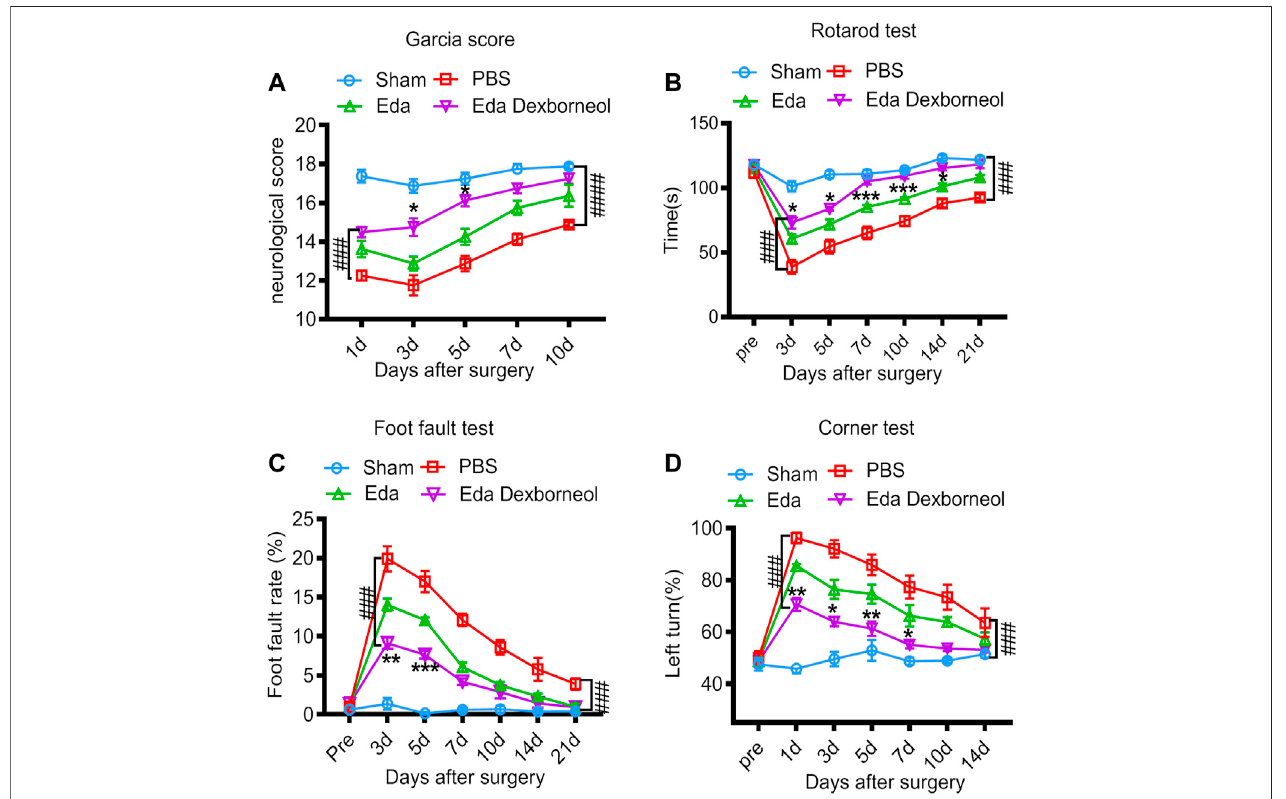
FIGURE 2 | Edaravone dexborneol treatment improves sensorimotor functions after SAH. (A) Neurological scores were determined 1 – 10 days after SAH with the modi fi ed Garcia scoring system. (B – D) Acute sensorimotor dysfunction at 1 – 21 days after SAH was assessed by (A) Garcia score, (B) rotarod test, (C) foot-fault test, and (D) corner test. N = 8/group. Data are given as mean ± SE. * p < 0.05, ** p < 0.01, *** p < 0.001 vs. Eda. ### p < 0.001, #### p < 0.0001 vs. PBS. Eda: edaravone; Eda dexborneol: edaravone